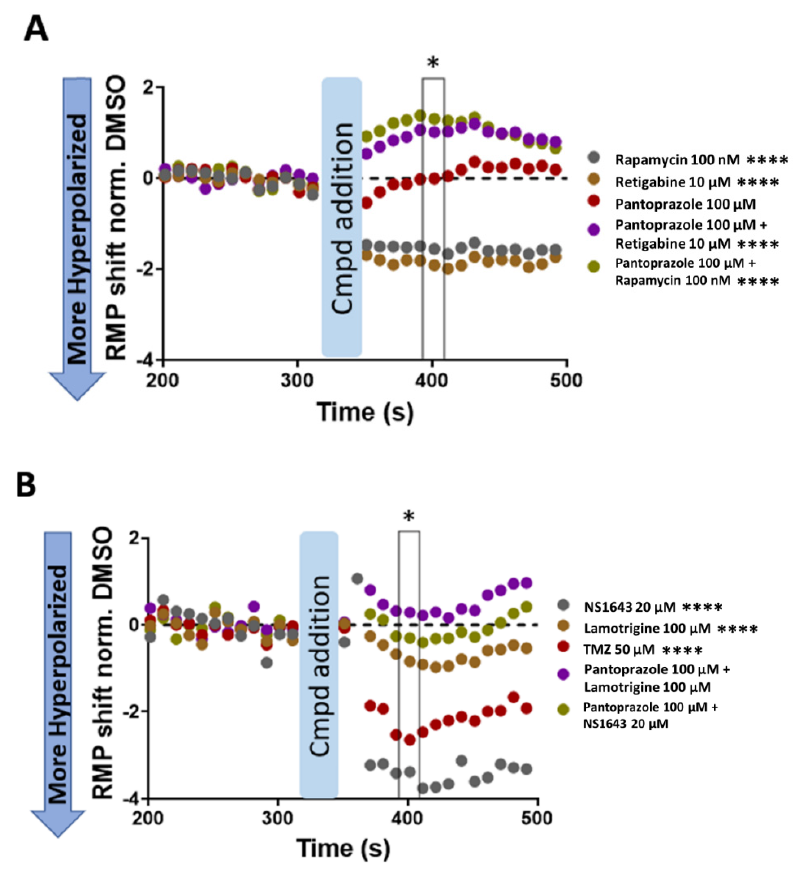
Figure 7. Resting Membrane Potential Changes Caused by Treatments in NG108-15 FUCCI Cells. The change in resting membrane potential is normalized to DMSO control. The negative values represent an increase in hyperpolarization. ( A , B ) were conducted on different days. There were n = 55–63 cells per condition. Statistics were calculated for the 400 s time point (black box with star on top). Significant values shown next to legend. ****: p < 0.0001, were calculated using an ANOVA with Dunnett post hoc